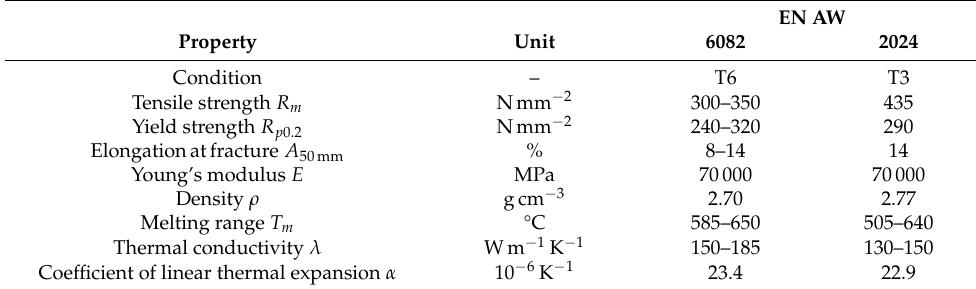
Table A2. Selected thermal and mechanical properties of aluminum EN AW-6082-T6 and EN AW-